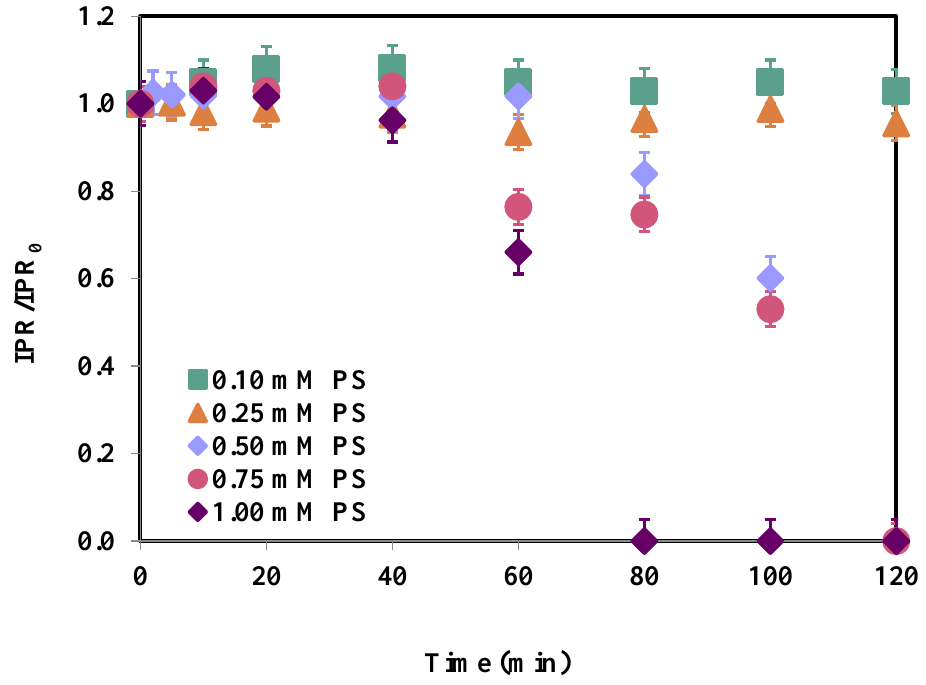
Figure 3. Changes in normalized IPR concentration during ZVI/PS treatments in DW at varying initial PS concentrations. IPR = 2 mg/L; ZVI = 1 g/L; pH = 5.0.